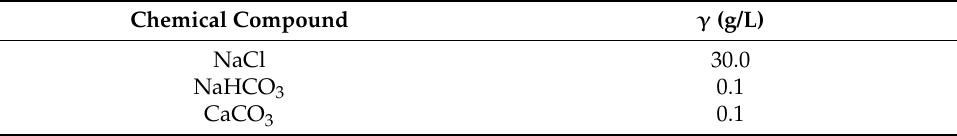
Table 2. Chemical composition of the simulated brine solution [23].